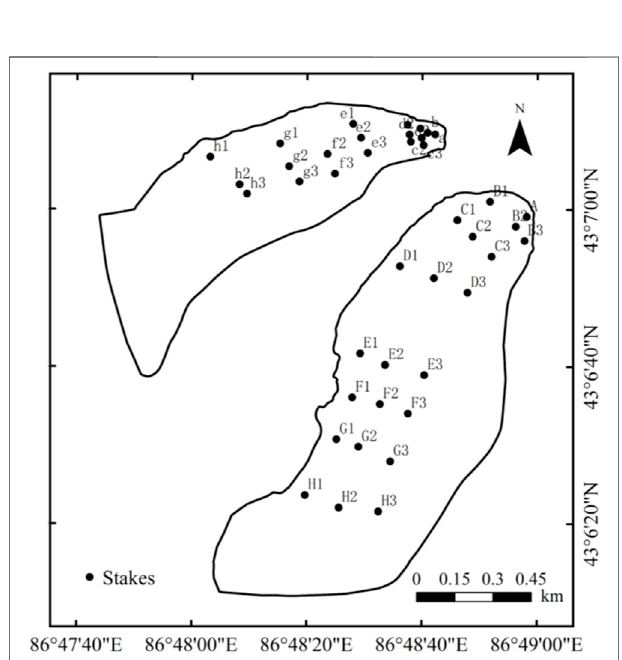
FIGURE 2 | (A) Surface and (B) bedrock DEMs of Urumqi Glacier No. 1 and the contour intervals both are 50 m.